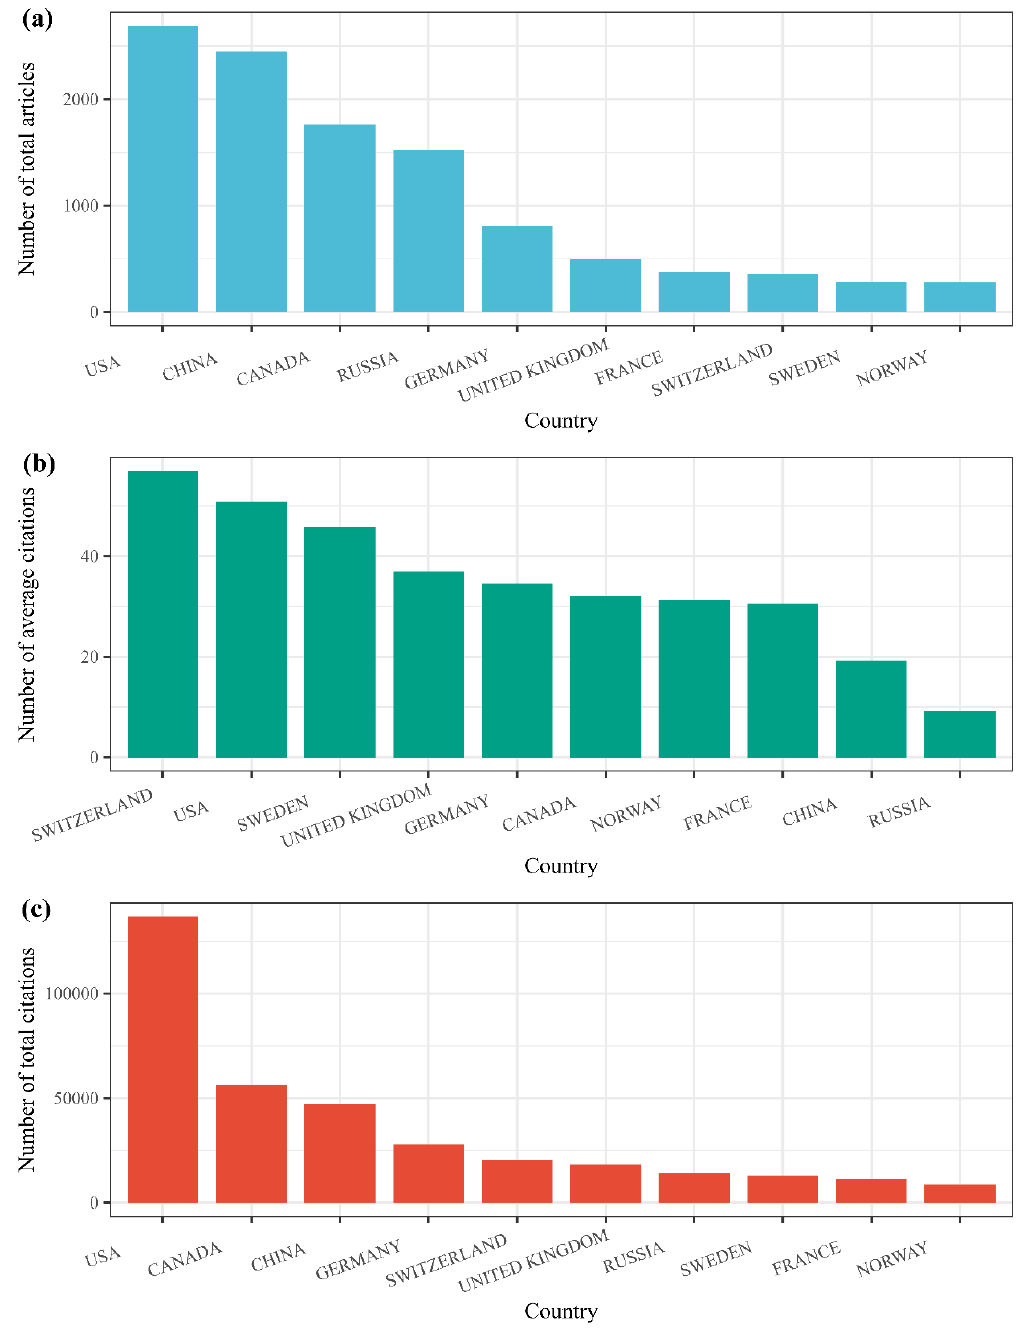
Figure 6. Total publications ( a ), average citations ( b ), and total citations ( c ) of the top ten most-cited countries. All are in descending order.